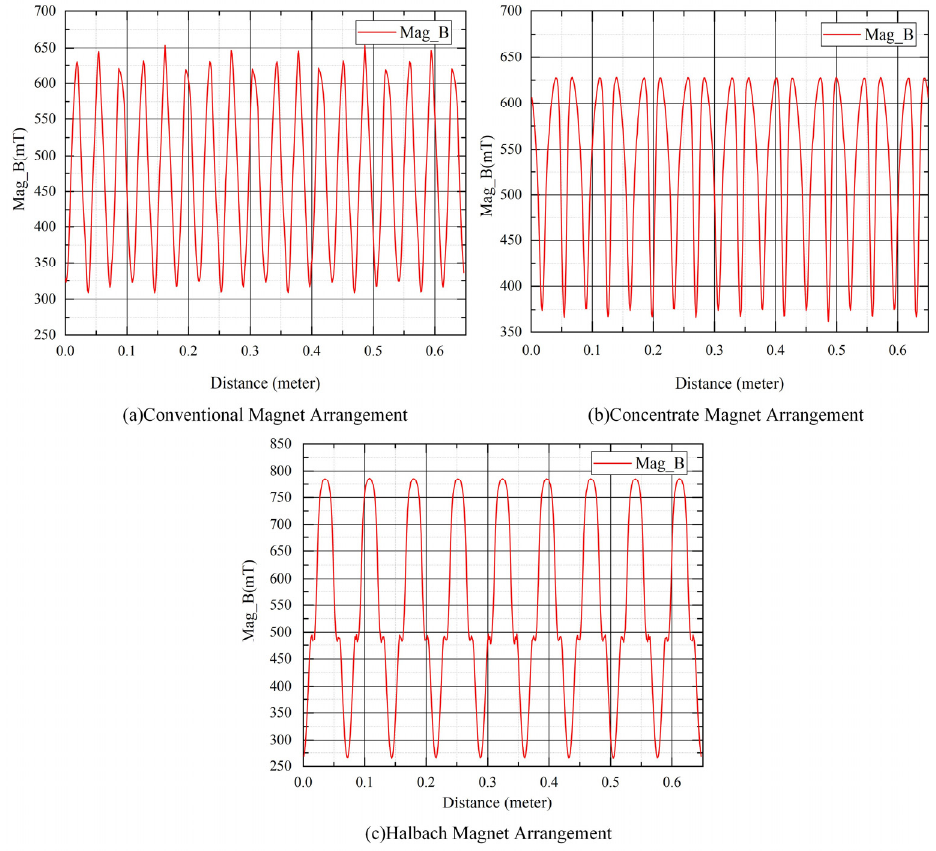
Figure 9. Magnetic flux density in the air gap along the tangential direction. Table 1. Comparison of the performance between different magnet